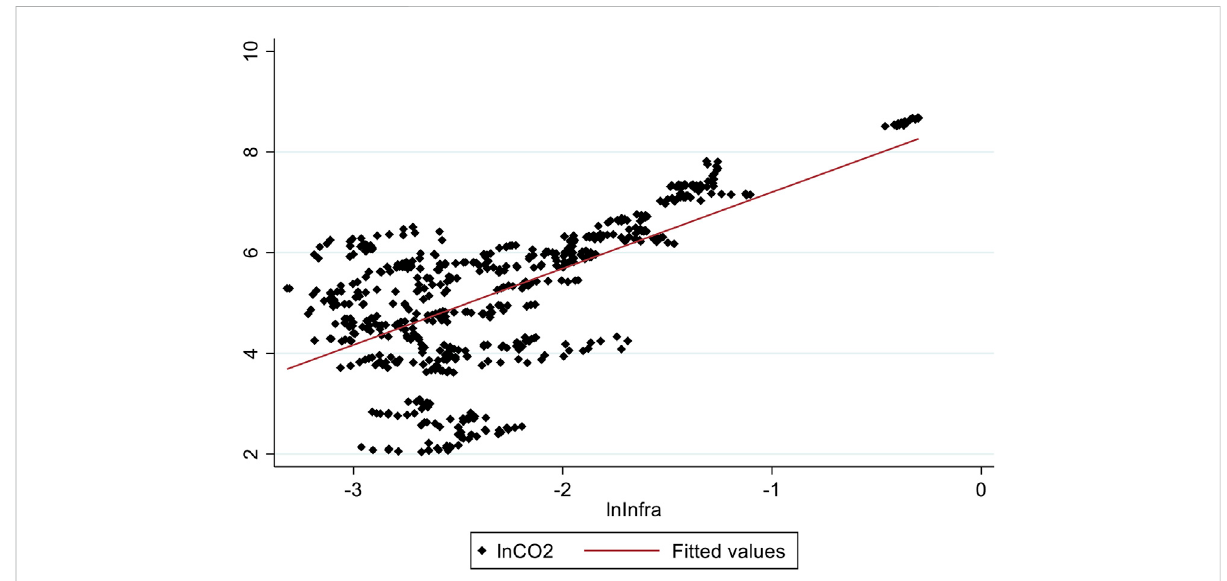
FIGURE 1 The correlation chart between infrastructure and CO 2 emissions.